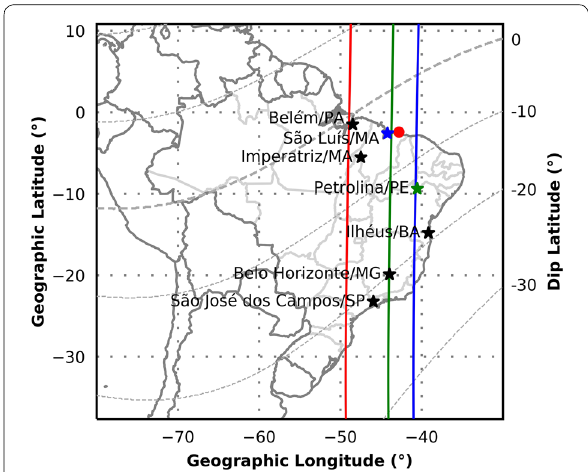
Fig. 2 Geographic location of São Luís (Digisonde, AFRL VHF and GPS Novatel and Septentrio receivers) is represented by blue star. The ionospheric piercing point (IPP) for the eastward VHF link is represented by the red circle. LISN (Low-Latitude Ionospheric Sensor Network) GPS Novatel receiver sites are shown as stars, except for Belém where there is just one magnetometer. The star is green at Petrolina where there is another magnetometer besides the LISN GPS receiver. SWARM-A satellite tracks ground projections are shown in green for the quiet day 03, in red for the first storm day 07 and in blue for the second storm day 08. The thick dashed line is the magnetic equator for September 2017, and the thin dashed lines represent the dip latitudes for each